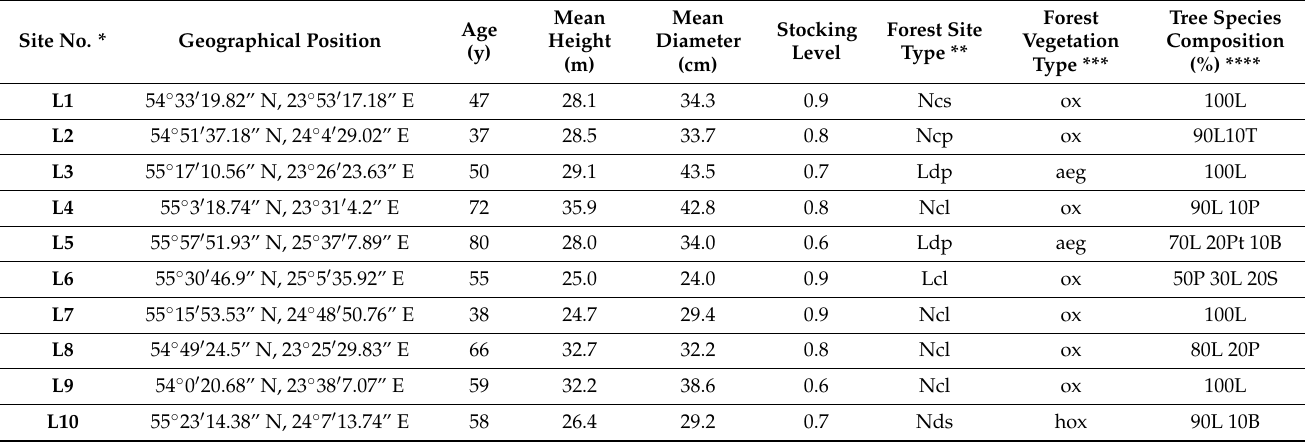
Table 1. Characteristics of investigated Larix spp. stands. Information is based on the forest inventory data obtained from the State Forest Cadastre as of 1 December 2020. Site No. * Geographical Position